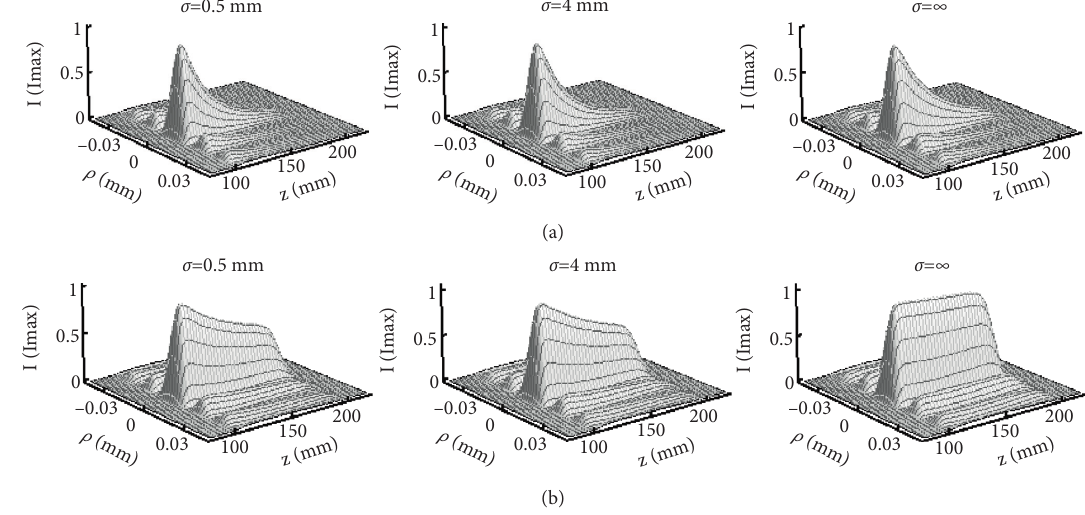
Figure 8: Normalized intensity distribution produced by annular-aperture logarithmic axicon by partially coherent Lorentz–Gauss beam with incident beam width of (a) w